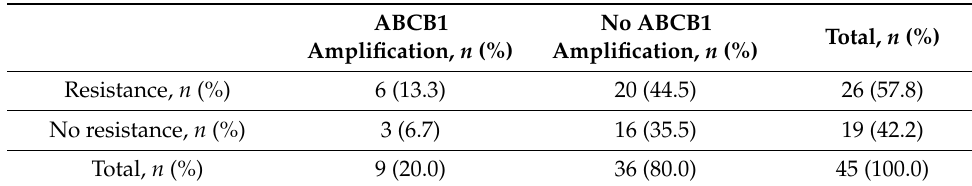
Table 2. Association between ABCB1 amplification and primary resistance to docetaxel in cohort A ( n =